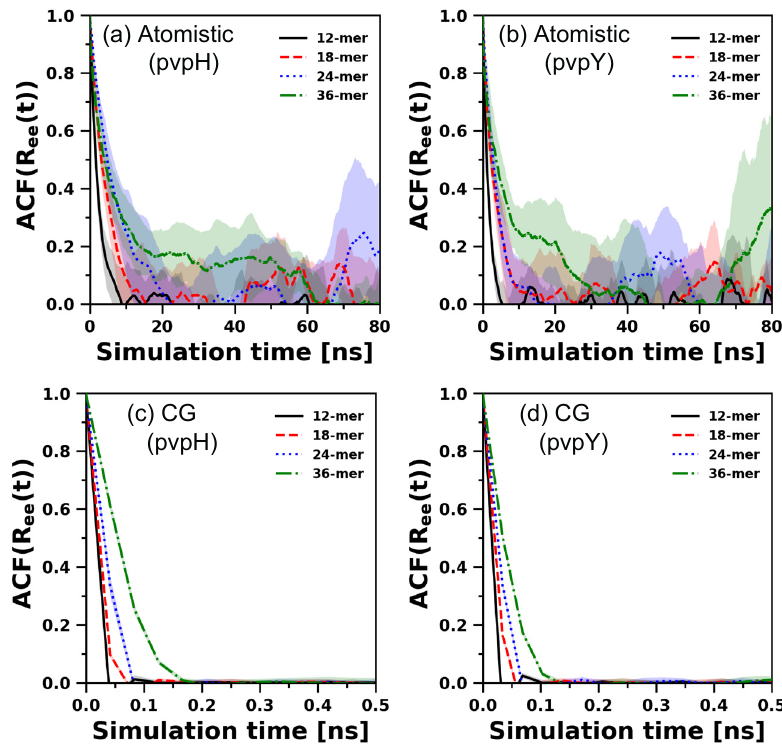
Figure 8. Comparison of end-to-end vector autocorrelation functions obtained from both atomistic ( a , b ), and CG simulations (with best performing parameters) ( c , d ), for pvpH and pvpY chains, of chain length 12-mer, 18-mer, 24-mer, and 36-mer. The average autocorrelation functions and standard deviations (shown as shaded region) are computed from the means of 5 independent trials for atomistic simulations and 10 independent trials for CG simulations. We note that (i) CG simulation time steps (in reduced units) are converted to real time units, for pvpH and pvpY separately, using the calculations shown in SI, and (ii) standard deviations for CG simulations are too small to be viewed.